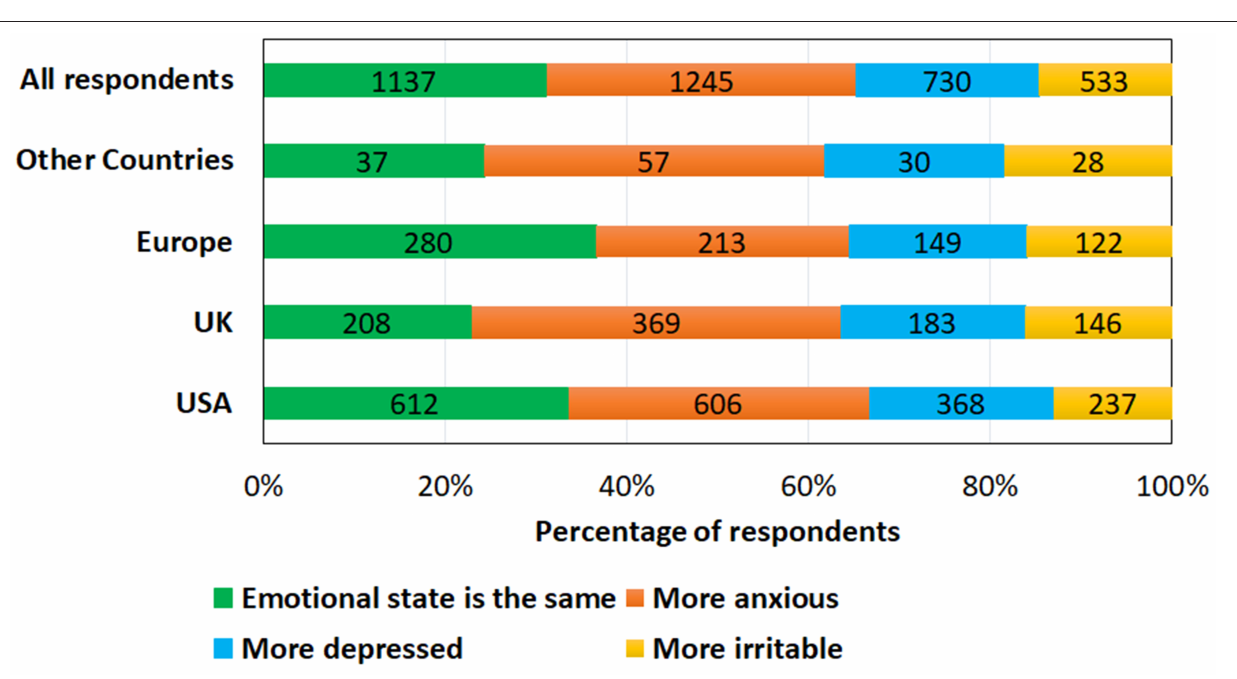
Frontiers in Public Health | www.frontiersin.org